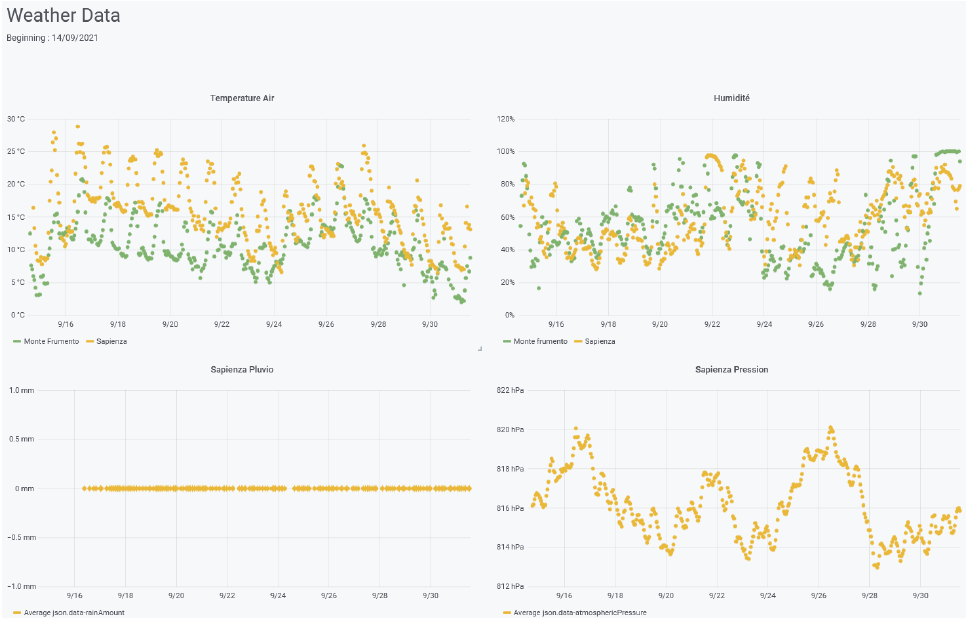
Figure 10. Extract of the dashboard of weather station at Mt. Etna (courtesy of LPC and